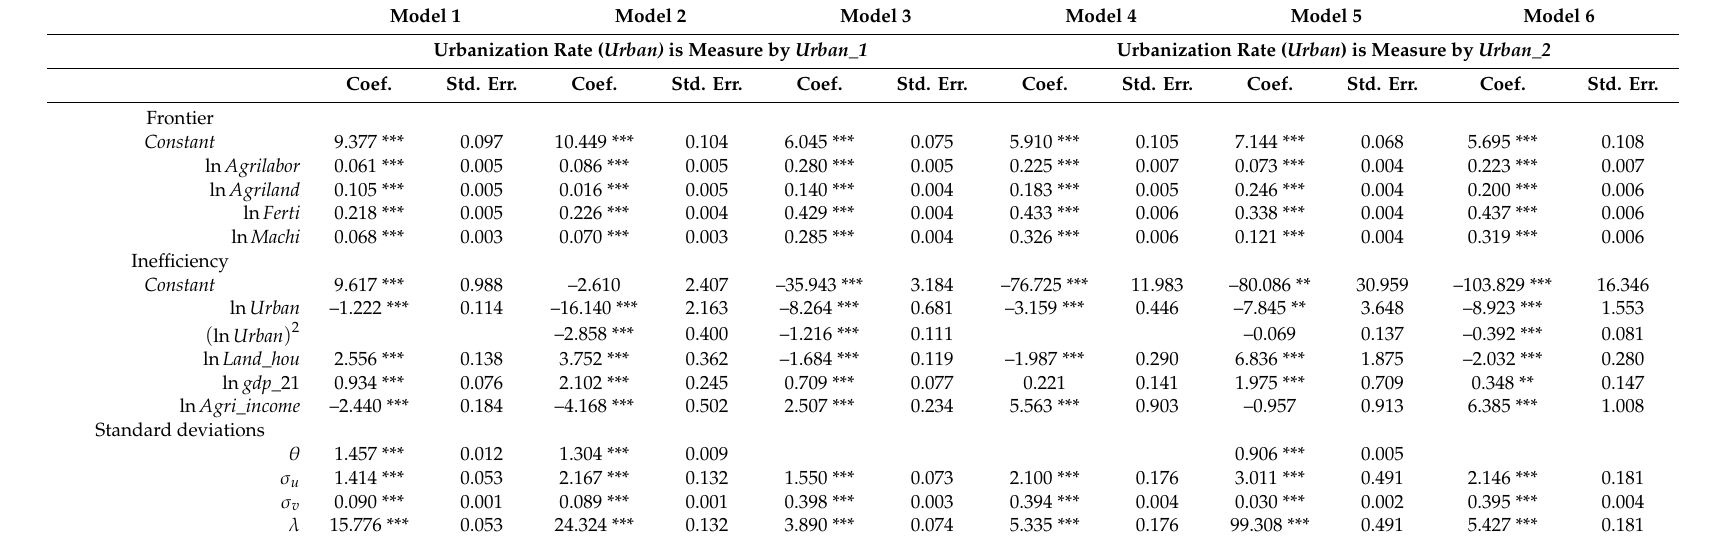
Table 2. The results of empirical test